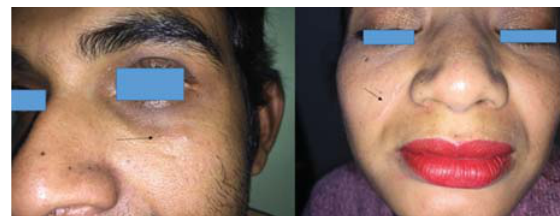
Figure 2. Results of both the techniques at the end of 6 months. a) Closure with Subcutaneous Continuous with absorbable sutures. The scar has near normal pigmentation, minimal relief, mildly thick and slightly expanded. b) Closure with Intradermal vertical mattress sutures. The scar has nearly